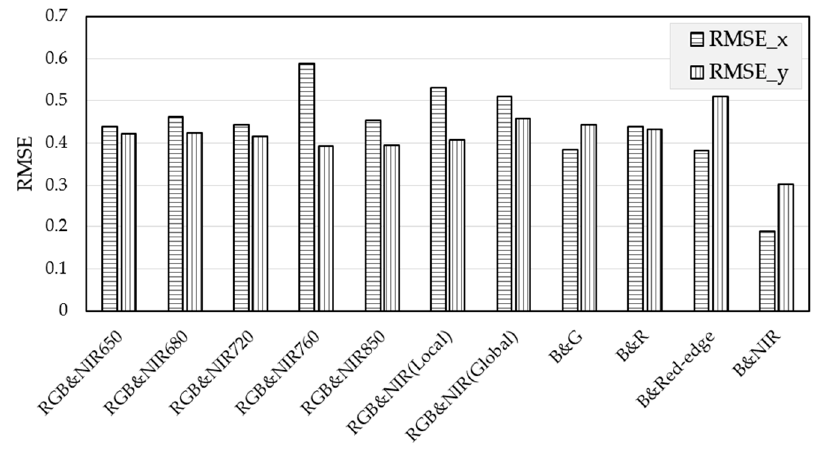
Figure 12. Mean registration root mean square error (RMSE) in x and y directions.